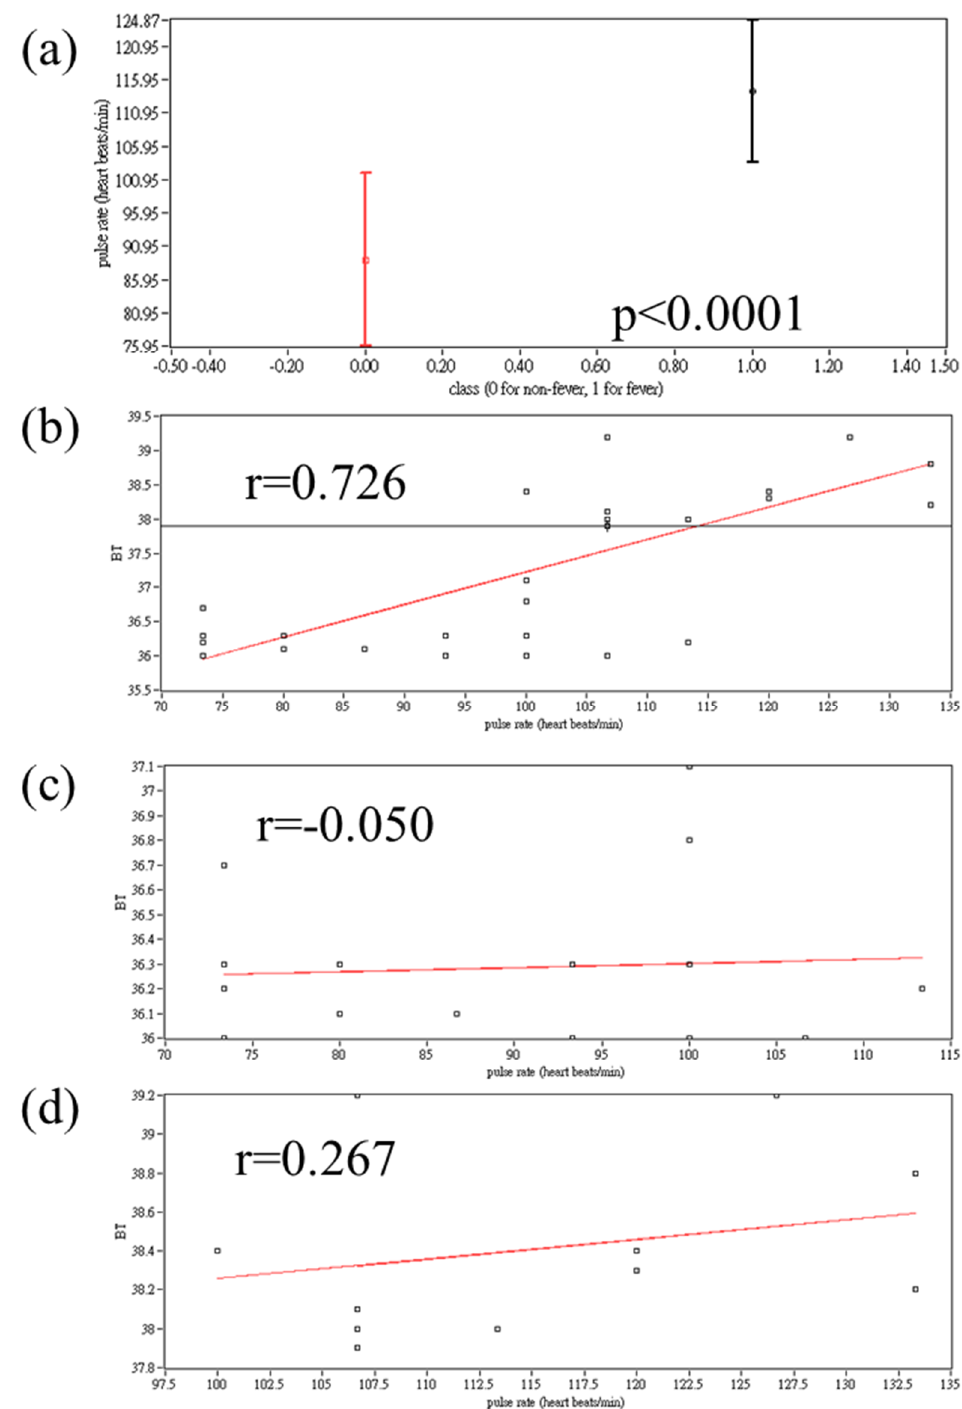
Figure 6. ( a ) Distribution of pulse rate of 2 groups; ( b – d ) Linear fitting and Spearman r value between body temperature and pulse rate in ( b ) total subjects; ( c ) Non-fever group; ( d ) Fever group.